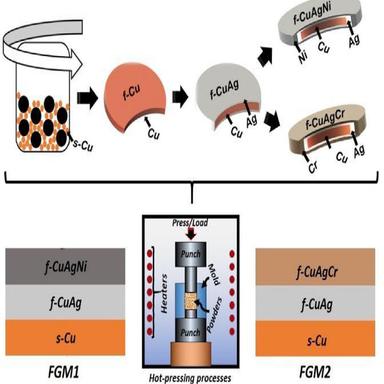
Symbolic representation of the fabrication stages of two- and three-layer powders and FGMs.